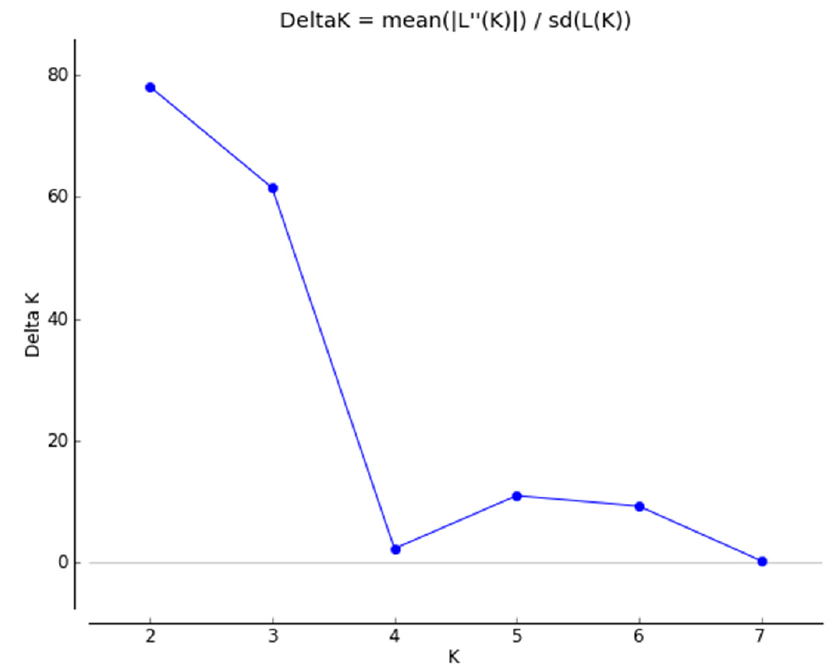
Figure 2. The highest likelihood and ∆ K were observed for K = 2 and K = 3.